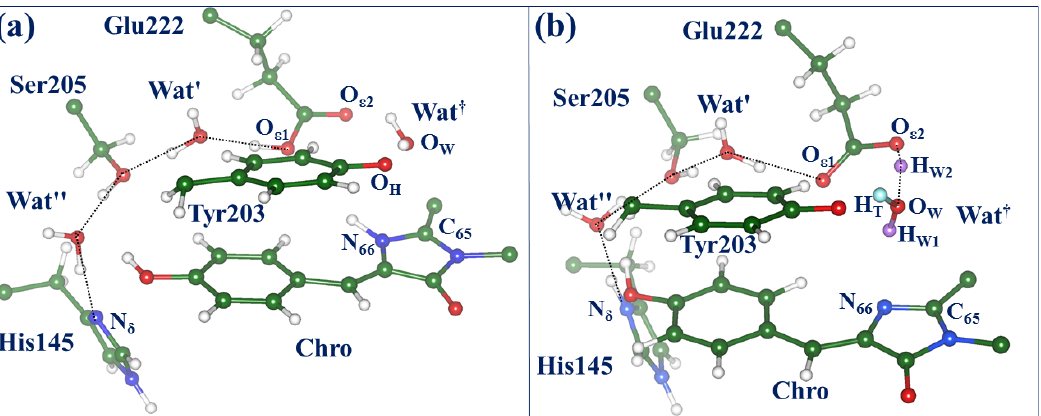
Figure 7. Structures of two possible conical intersection points CT/S 0 on the ON → OFF photo-induced pathways. ( a ) The case of the neutral His145 and neutral Glu222 (see also Figure 4). ( b ) The case of the protonated His145 and initially deprotonated Glu222. In both cases, proton wires connecting atoms O ε1 (Glu222) and N δ (His145) are shown by dotted lines. Symbol Wat† refers to the transient triatomic species formed from the reactive water molecule Wat and the proton from Tyr203.